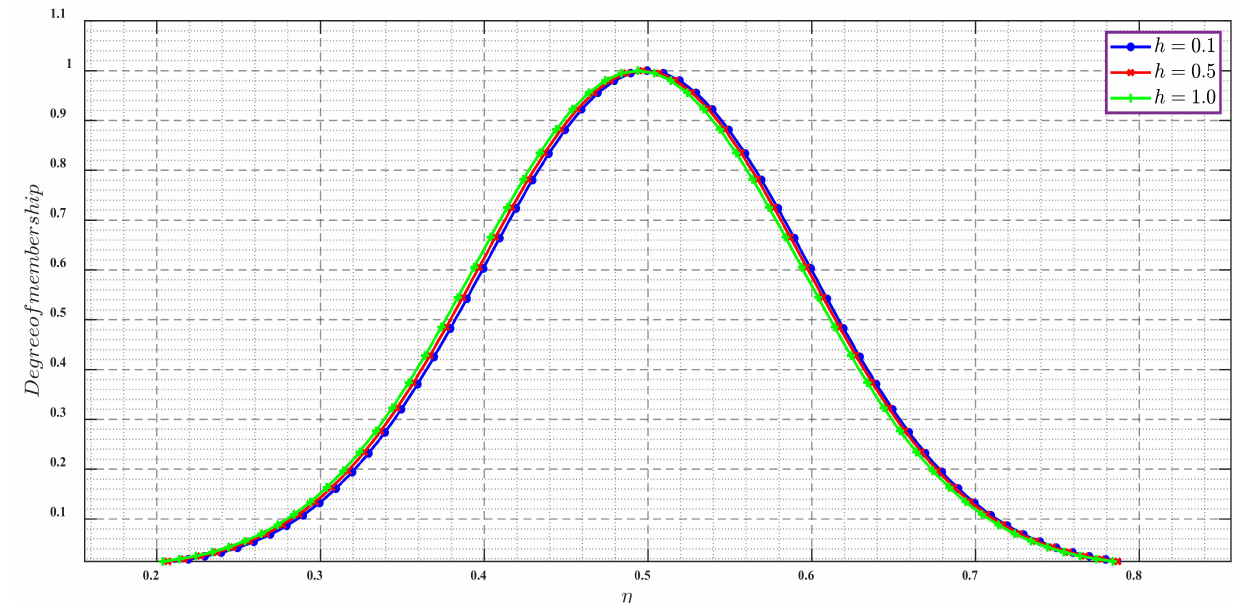
Figure 15. Fuzzy solution of η by SHPM at t = 0.1